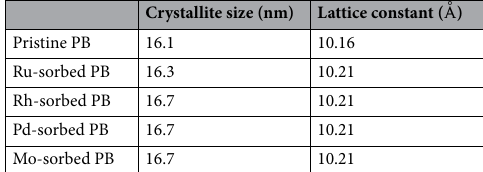
Crystallite size (nm) Lattice constant ( Å